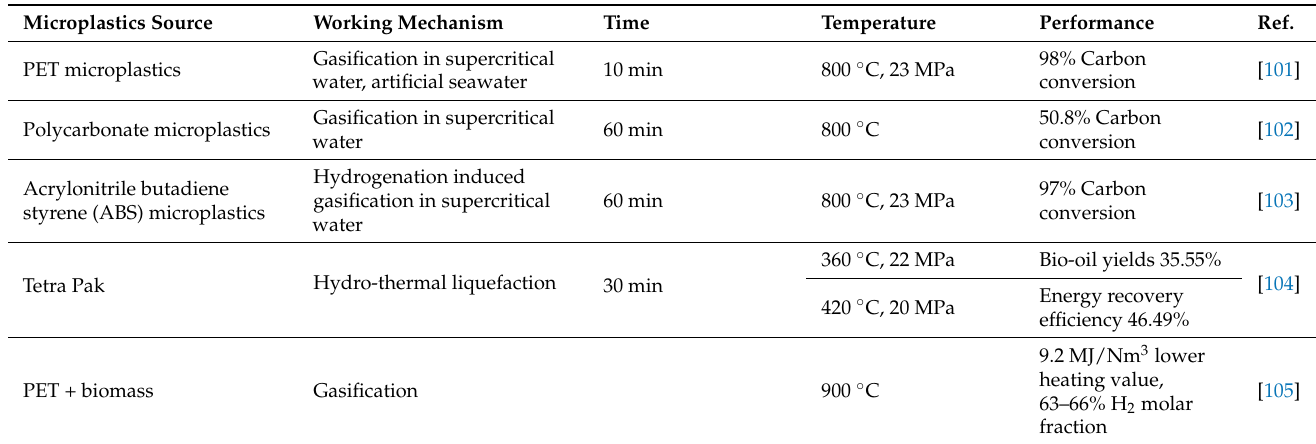
Table 4. Summary of research on the thermal degradation of